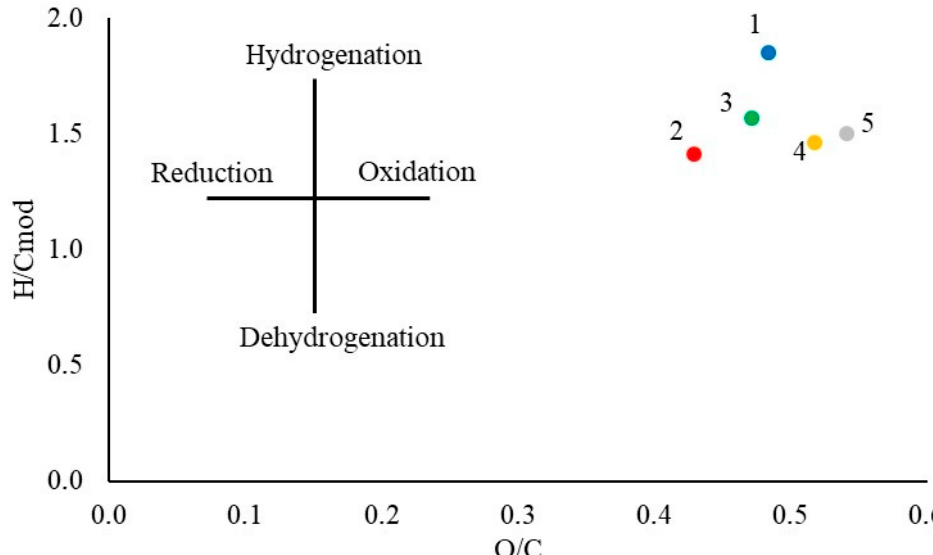
Figure 2. The van Krevelen diagram of the elemental composition of HAs. Sample No. corresponds to Table 1: 1—Control; 2—Crown fire, 2010; 3—Surface fire, 2010; 4—Crown fire, 2020; 5—Surface fire, 2020.